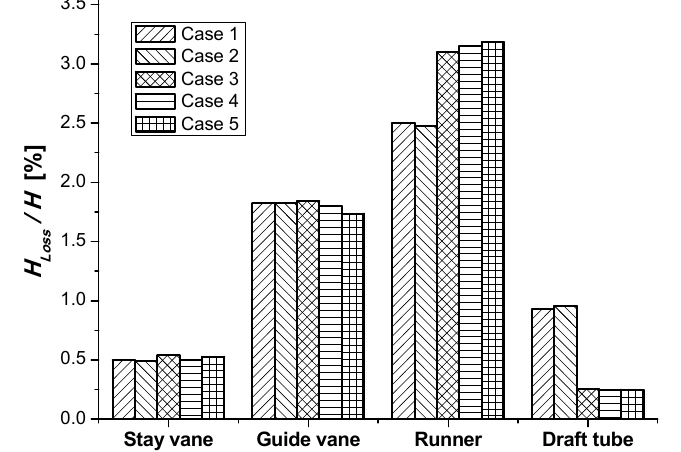
Figure 13. Loss distribution on each component.